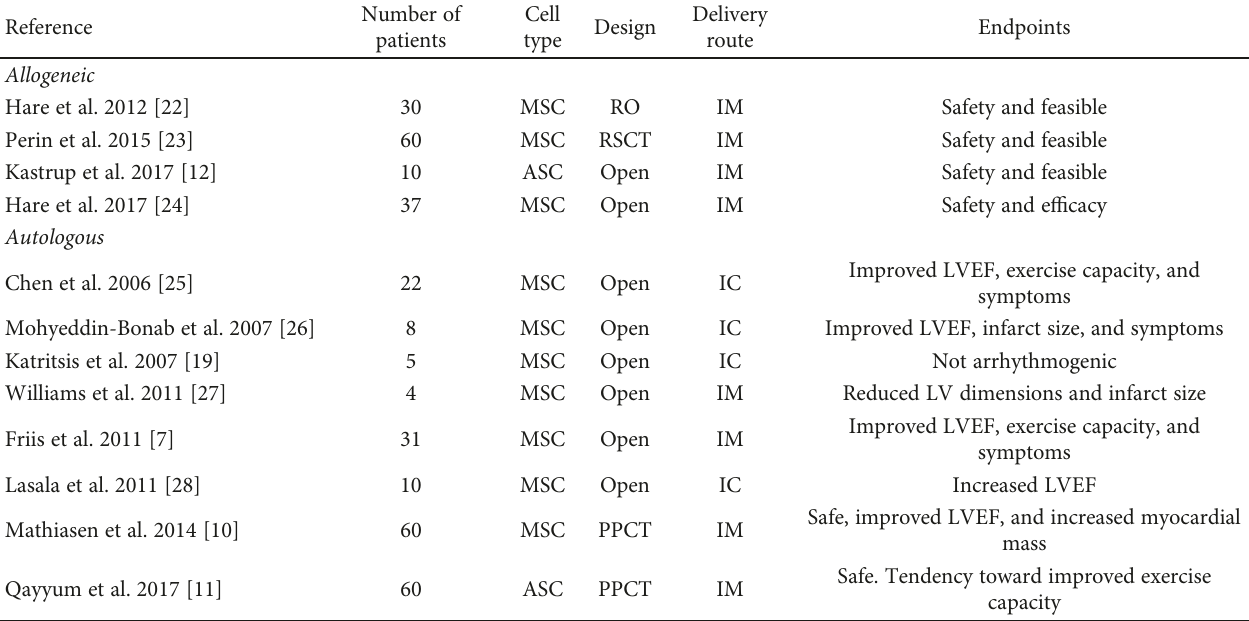
Table 4: Mesenchymal stem cell trials in patients with chronic ischemic heart disease.